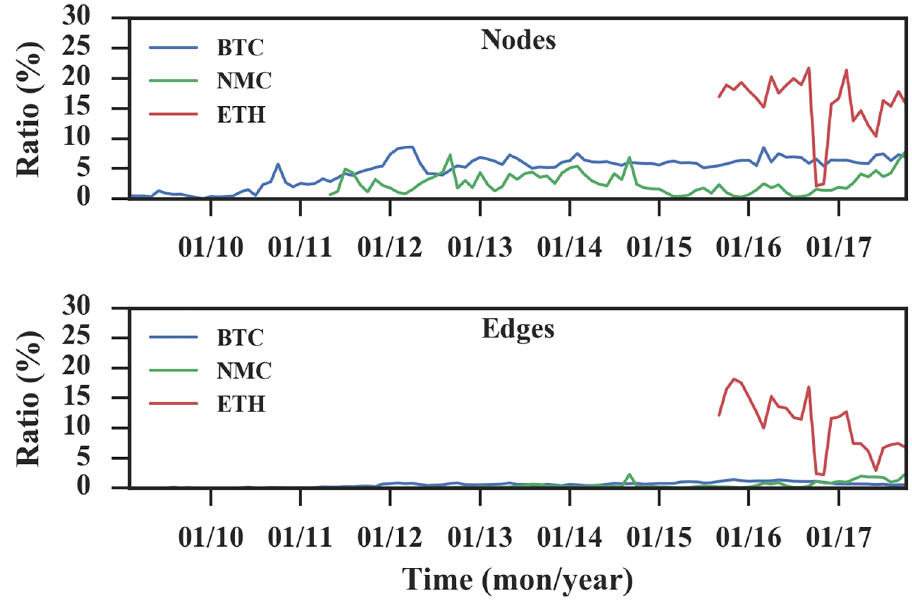
Fig 5. Monthly repetition ratios over time. (A) The ratios of edges. (B) The ratios of nodes. After the initial phase, all ratios reach relatively low